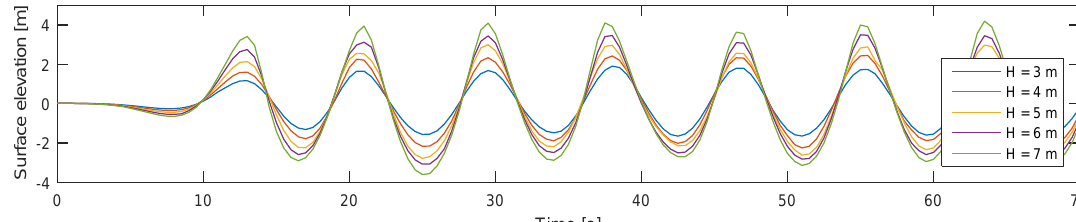
Figure 5. Surface elevation of the modeled incident waves. The wave period was 8.5 s, and five different wave heights were simulated.